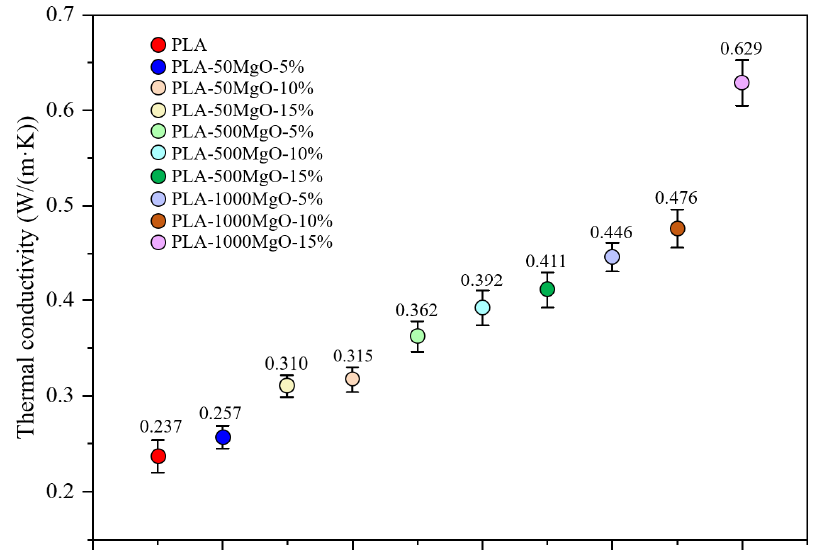
Figure 2. Thermal conductivity of polylactic acid composites doped with different particle sizes and mass fractions of MgO.